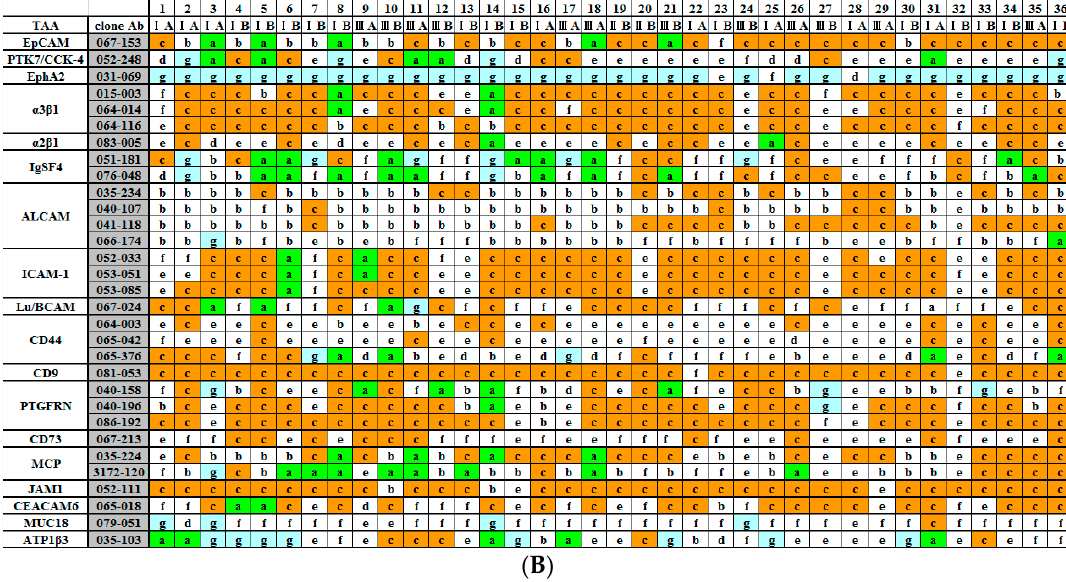
Figure 2. Results of the histochemical analyses. The total of 2160 IHC (immunohistochemical) patterns were classified into 1 of 7 categories. The definition of respective category is described in the text and the examples of IHC patterns are shown in Figure 1. Category a , c and g are marked in green, orange and blue, respectively. ( A ) The results with Abs (antibodies) against 9 TAAs (tumor-associated antigens) indicated that these Abs could be candidates as therapeutic drugs, since these Ags could be considered as authentic TAAs; ( B ) The results with Abs against 18 Ags indicated that these Ags could not be considered as TAAs.